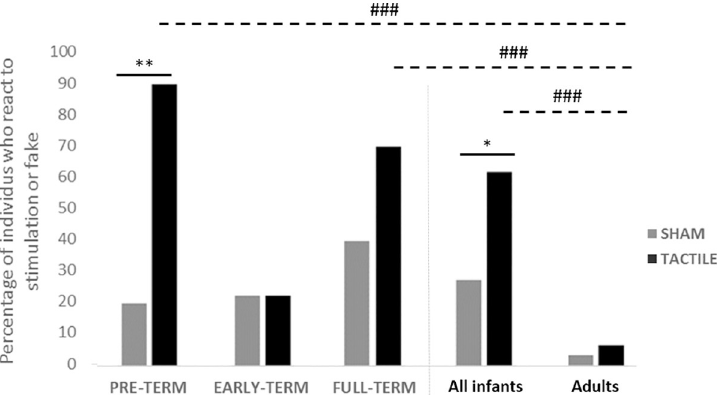
Fig 1. Percentage of preterms, early-terms and full-terms, as well as adults reacting respectively to the tactile and sham stimulations. Statistical analyses: McNemar’s tests: � P < 0.05, �� P < 0.01; Fisher tests, # # P < 0.01; # # # P < 0.001.